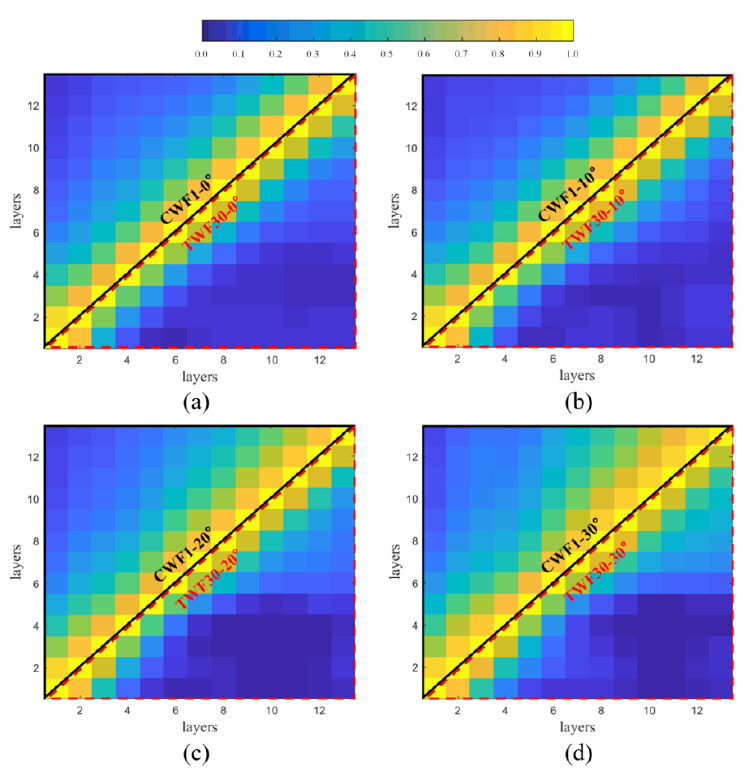
Figure 17. Correlation coefficients of along-wind load among different layers: ( a ) θ ref = 0 ◦ ; ( b ) θ ref = 10 ◦ ; ( c ) θ ref = 20 ◦ ; and ( d ) θ ref = 30 ◦ .